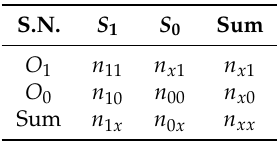
Table 4. Set-up of the 2 × 2 contingency table for binary snow cover data comparison. O and S , respectively, represent observed and simulated binary snow cover and the subscripts refer to a snow-free (0) and snow-covered (1) grid